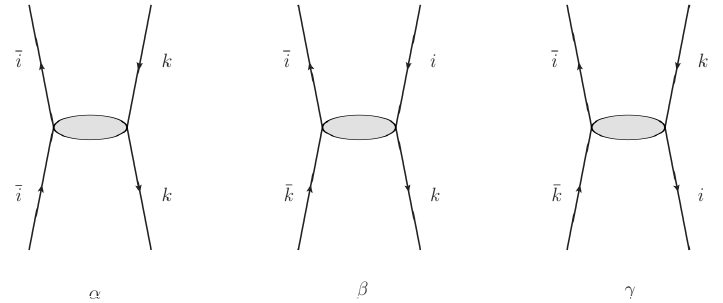
Figure 8 . Comparison between the meson propagator constructed by an invariant tensor ( α ) and two dyadic tensors ( β and γ